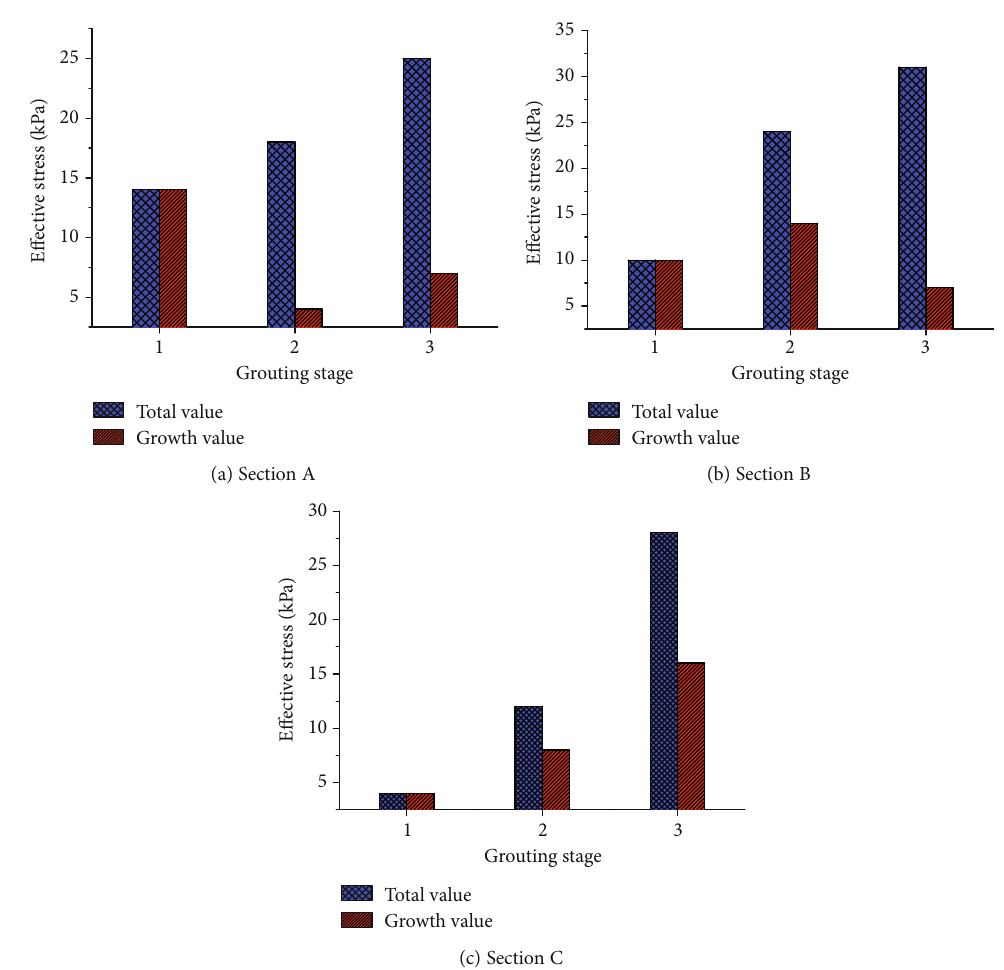
Figure 14: Variation of e ff ective stress in di ff erent grouting